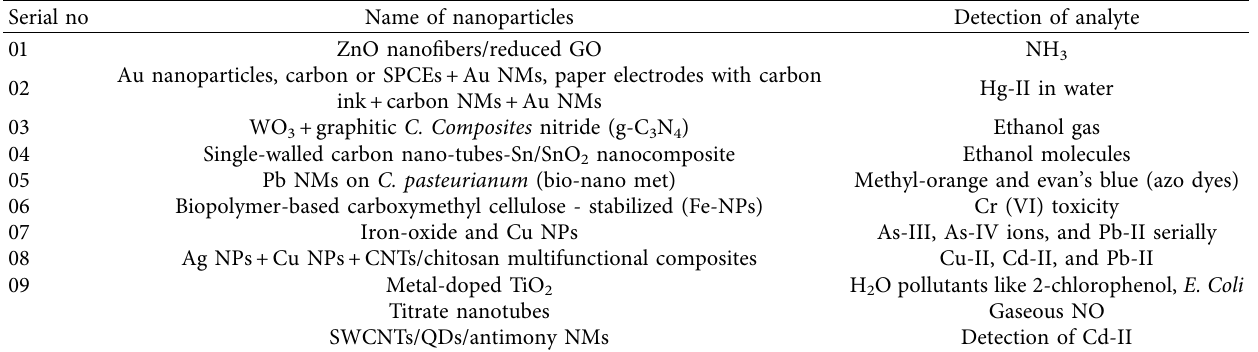
Table 5: Numerous nanoparticles for various analyte detection [243,